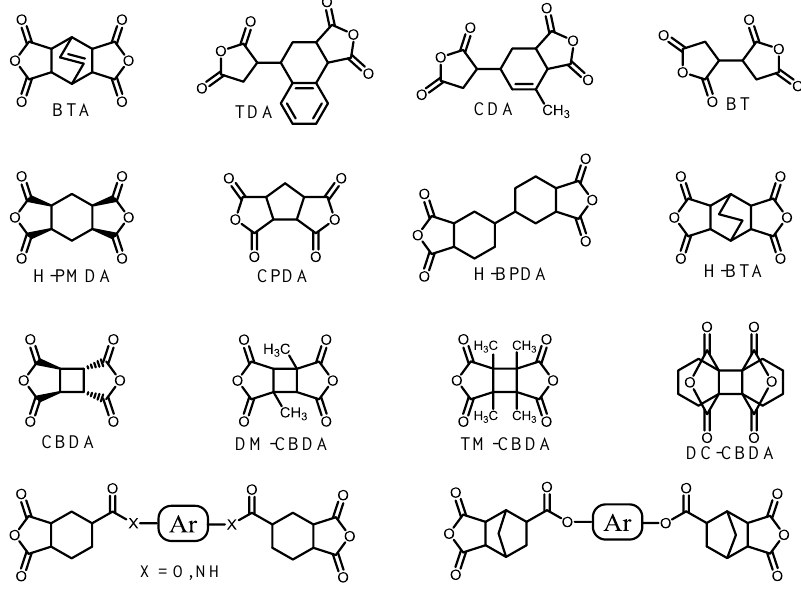
Figure 11. Commercially available cycloaliphatic tetracarboxylic dianhydrides (two monomers shown in the bottom are those prepared by the author’s group).